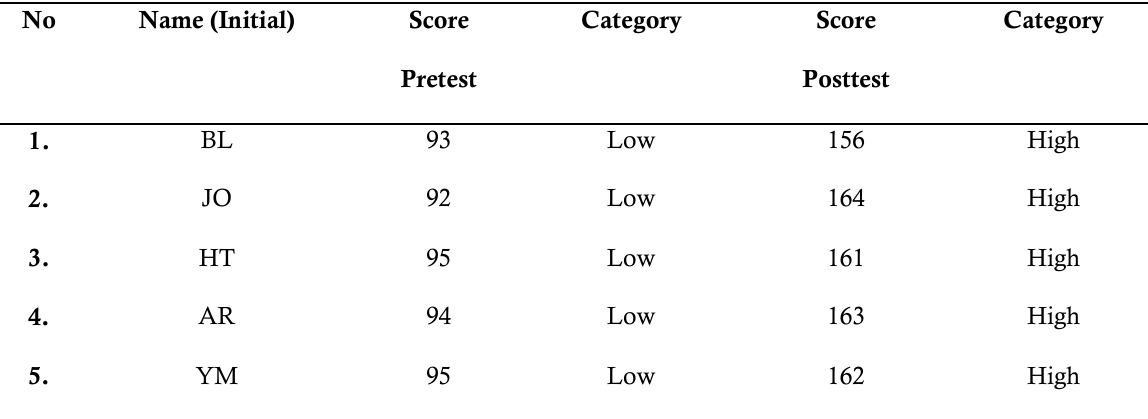
Table 1. Pretest and Posttest Results of Experimental Social Skills